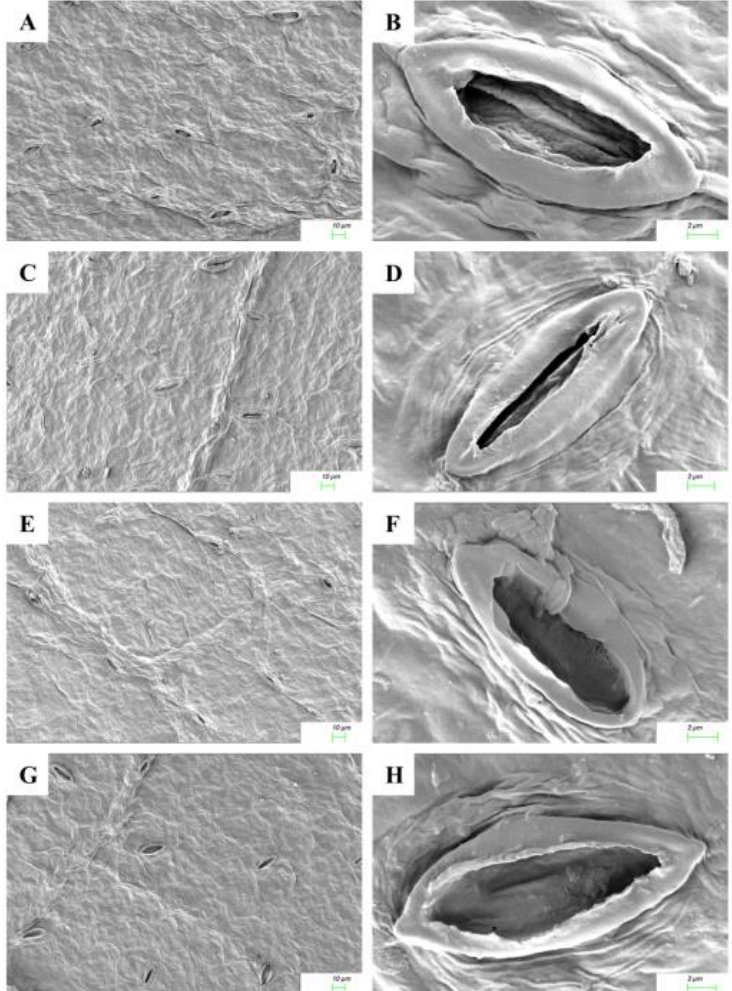
Figure 5. Scanning electron micrographs of abaxial leaf surfaces and stomata of the cotyledonary leaves of R. communis after 6 day of exposure to CuSO 4 (160 µM) and cytokinin (KIN and BAP) treatments in Hoagland’s nutrient medium. ( A )&( B ): Control; ( C )&( D ): 160 µM CuSO 4 ; ( E )&( F ): 160 µM CuSO 4 + KIN; ( G )&( H ): 160 µM CuSO 4 + BAP.